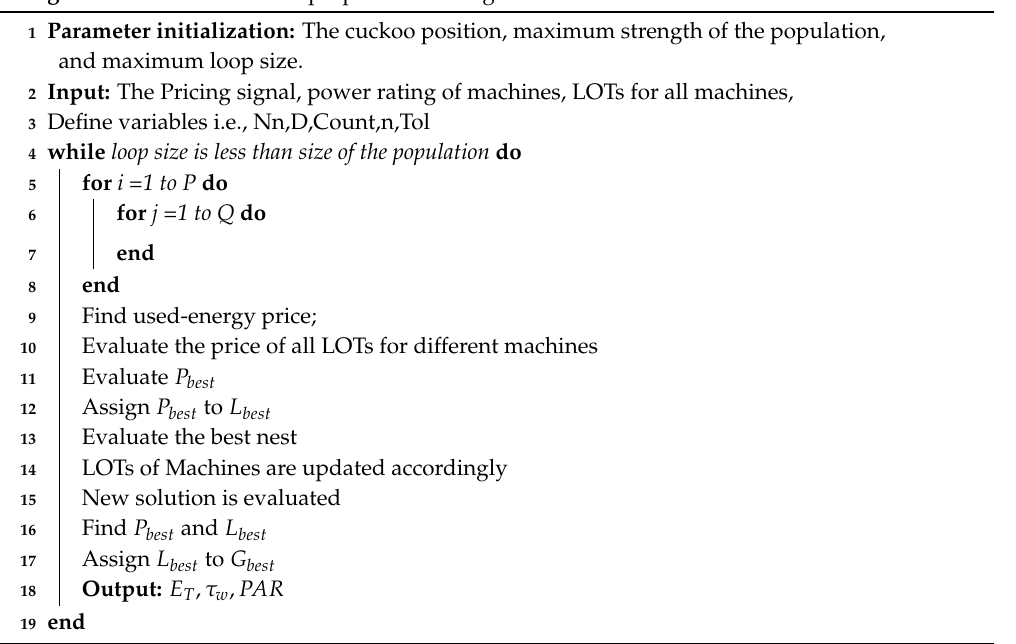
Algorithm 2: Pseudocode of proposed CSA Algorithm.